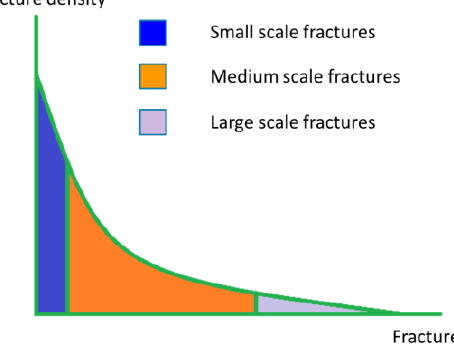
Figure 1. Fracture density and fracture length correlation.